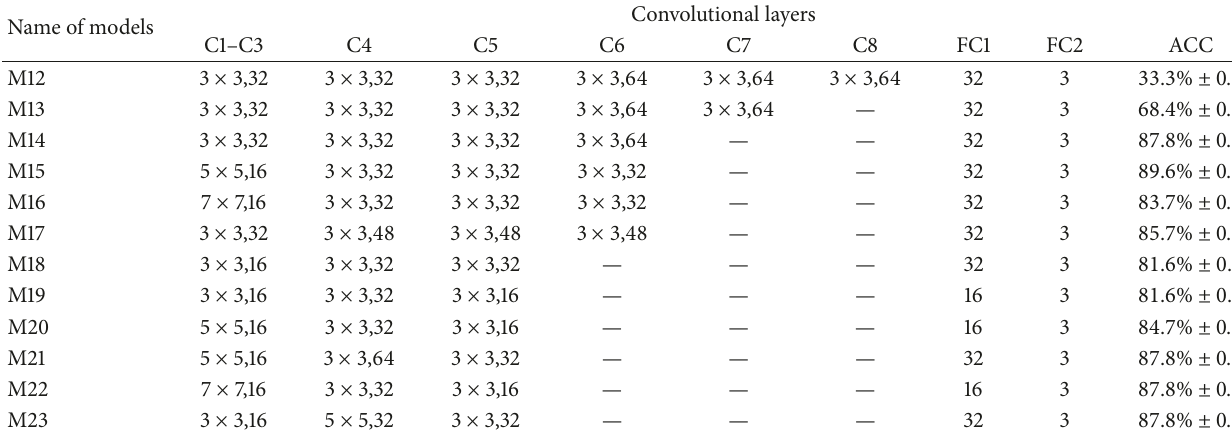
Table 2: Architecture of models with one convolutional layer before merging.